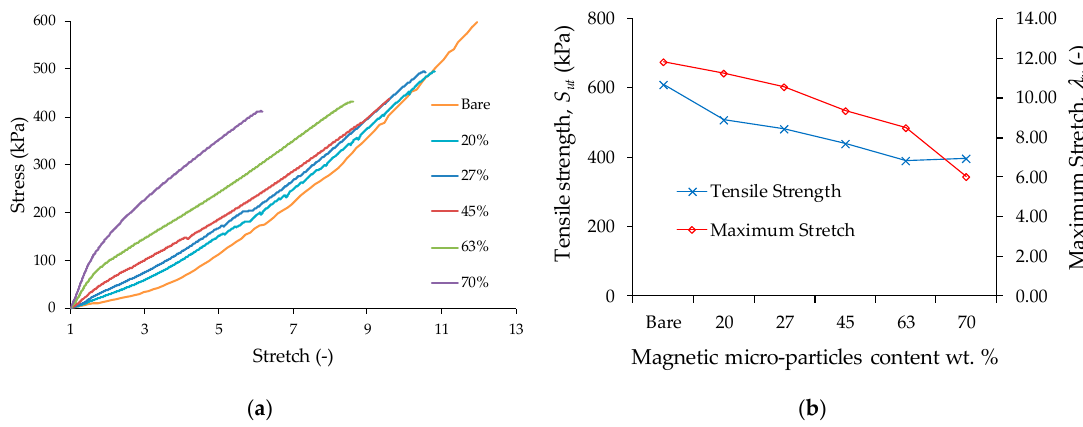
Figure 12. ( a ) Tensile test curves for the bare polymeric matrix sample and for composite material samples with 20, 27, 45, 63 and 70 wt % of CIPs, as the percentage of magnetic microparticles inside the material increases, the material stiffness increases. Also, there is a significant change in the material behavior, the bare and low CIP content (20 and 27 wt %) materials exhibit a nonlinear stiffening behavior, while the materials with high content of magnetic particles (45, 63, and 70 wt %) in the composite material exhibit a nonlinear softening behavior. ( b ) Tensile strength and maximum stretch for the samples shown in ( a ): as the CIP content in the composite material increases, both the tensile strength and maximum stretch decrease.